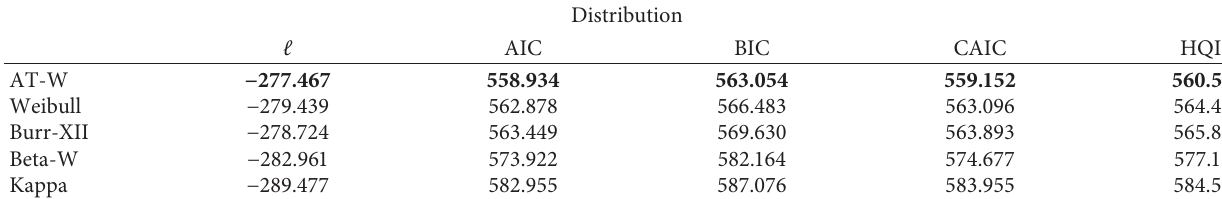
Table 7: The AIC, BIC, CAIC, HQIC, and likelihood values for the insurance data.